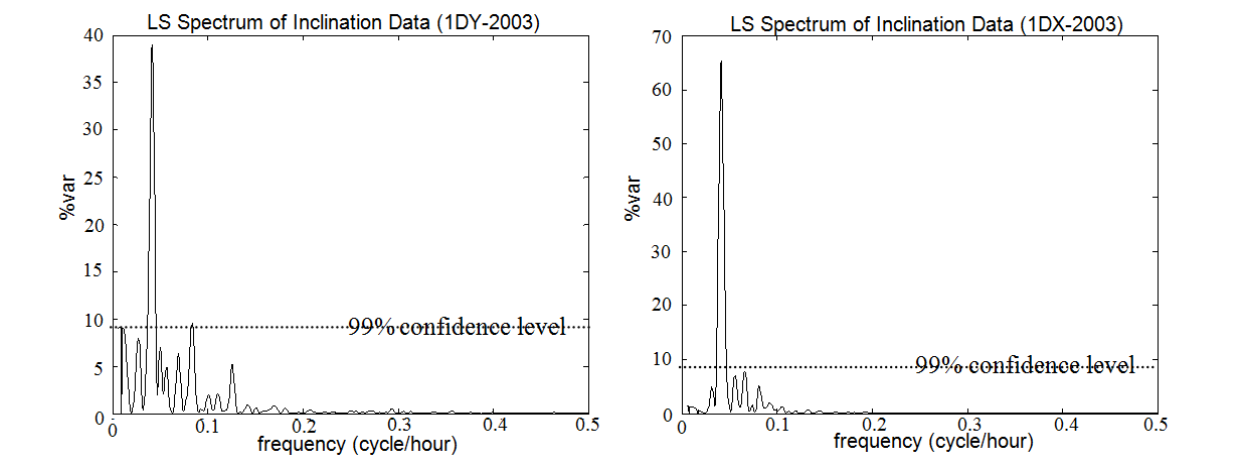
Figure 8. LS spectrum of weekly observations